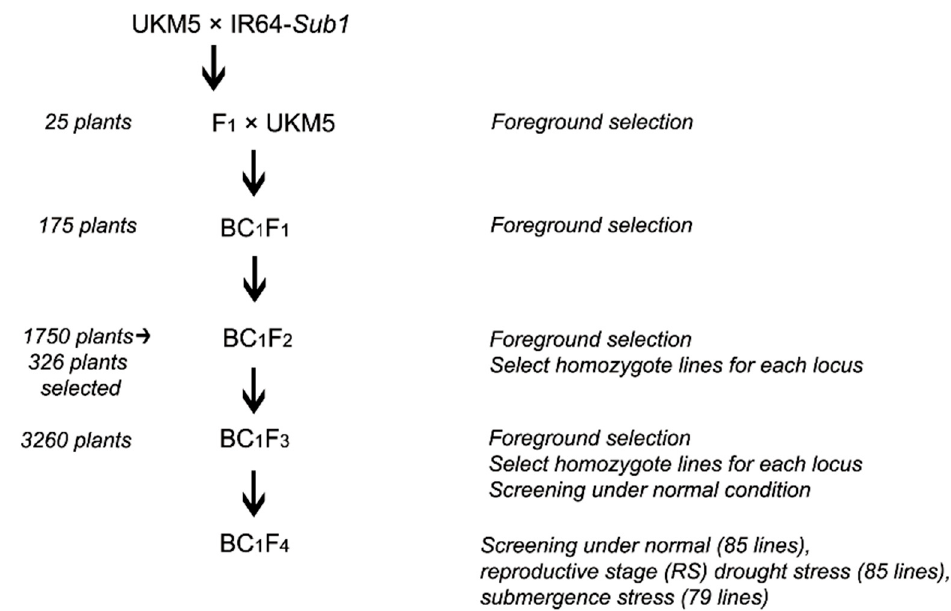
Figure 4. Crossing scheme for the development of BC 1 F 4 lines.